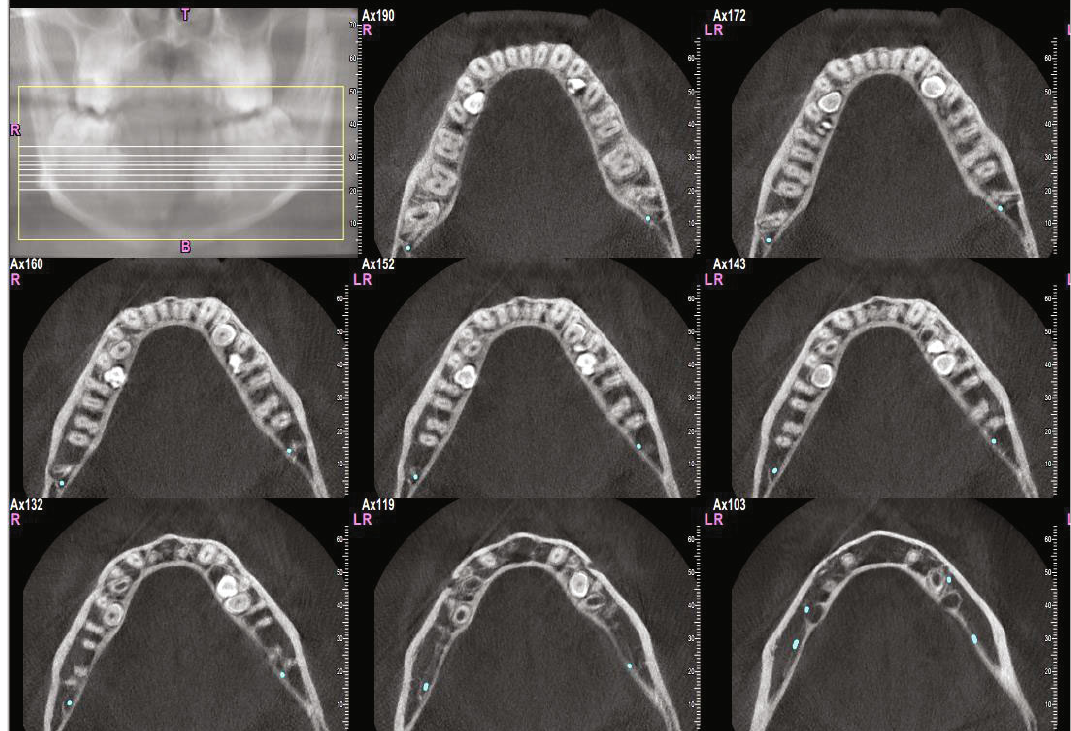
Figure 4: Transverse sections of the mandible, showing transverse sections of the mandibular supernumerary